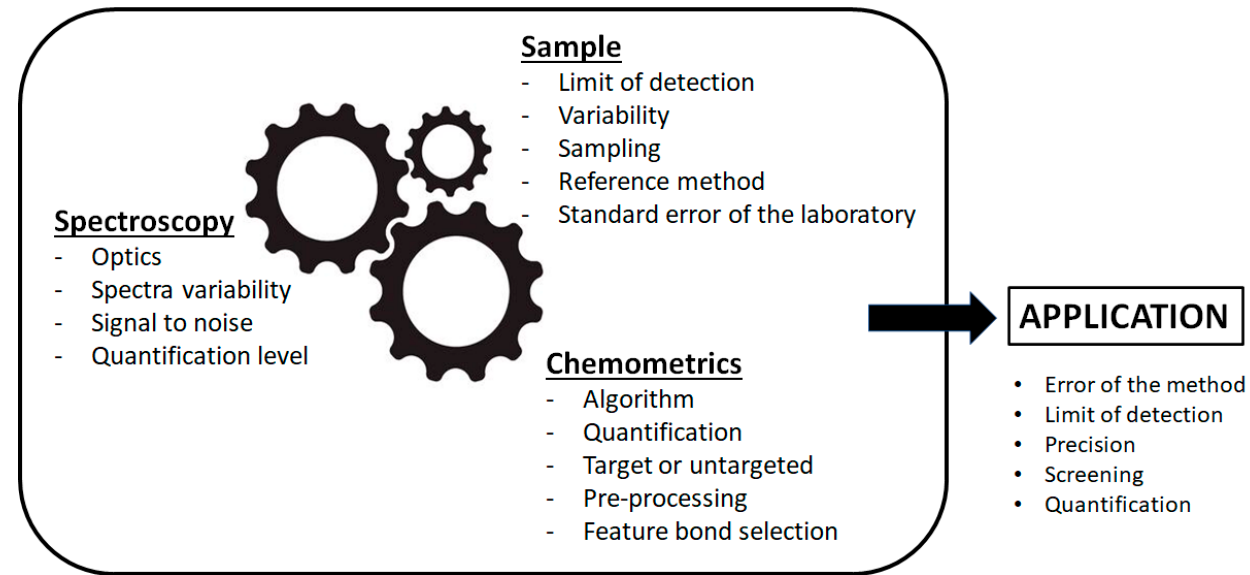
Figure 1. Schematic representation of how the spectroscopy, the sample and the chemometrics are interconnected to define the application.